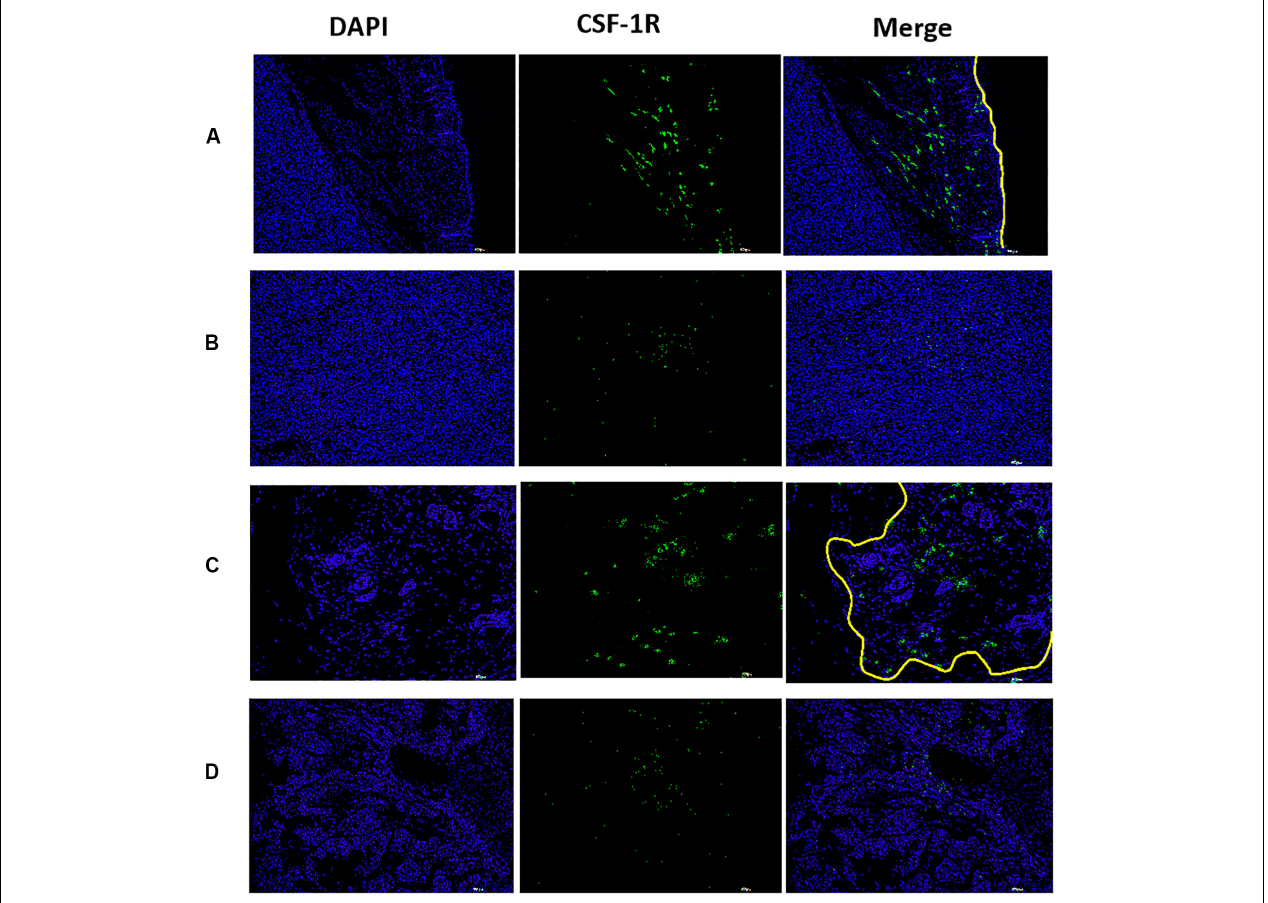
FIGURE 9 | The distribution of CSF-1R in xenograft tumor observed by fluorescence immunoassay, higher fluorescence intensity was observed at the peritumor, lower fluorescence intensity was observed at the tumor center. [ (A) boundary of the tumor, (B) central of tumor, (C) boundary of the residual tumor after IRFA, and (D) residual tumor after IRFA. With a scale bar of 200 µ m. The yellow line showed the tumor